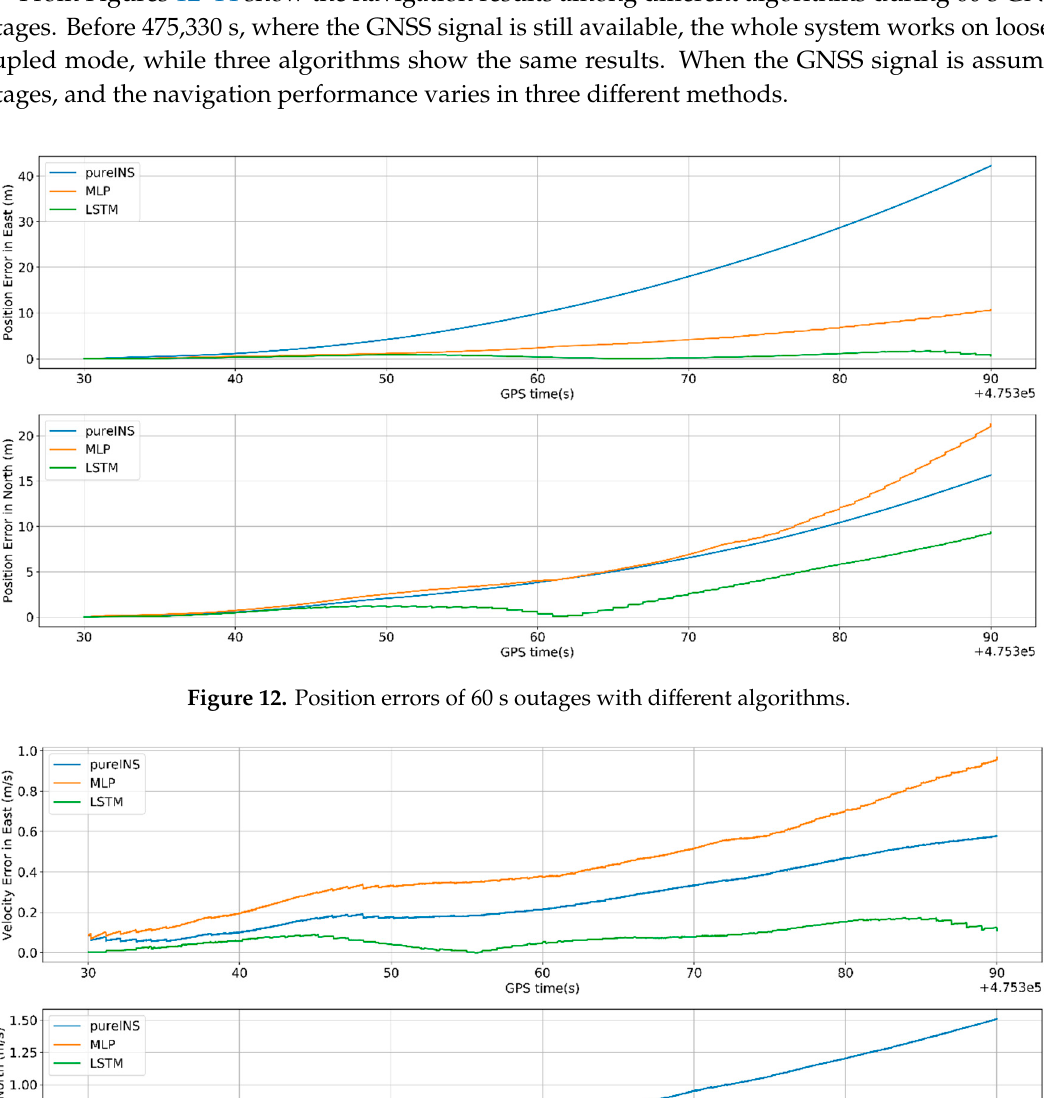
Table 5. Max error of position, velocity, and heading during 60 s GNSS outages in different algorithms.